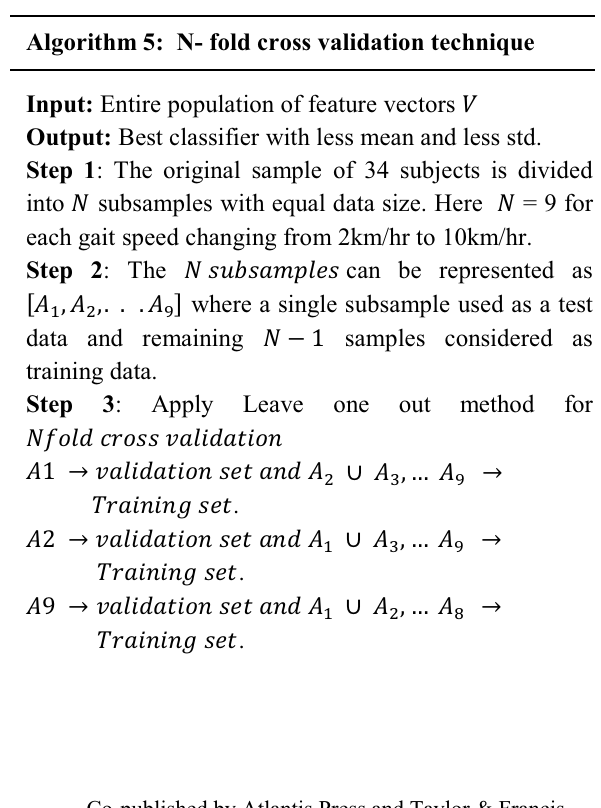
Algorithm 5: N- fold cross validation